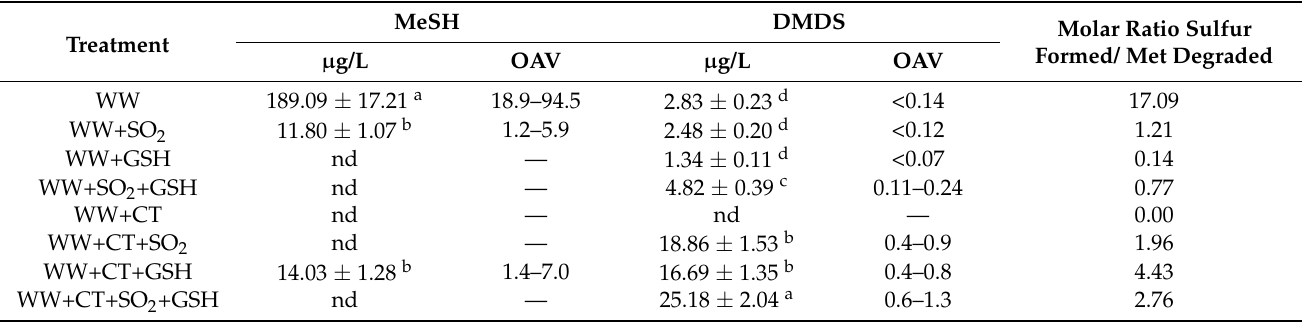
Table 4. Concentrations ( µ g/L) of methanethiol (MeSH) and dimethyl disulfide (DMDS) determined in white wine (WW) samples.